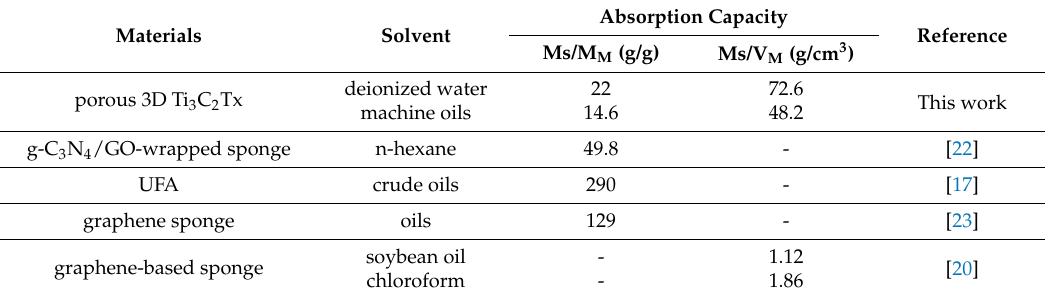
Figure 2. SEM images of the ( a ) 3D porous Ti 3 C 2 T x , ( b ) skeleton construction, ( c ) pores in the wall, and ( d ) 3D porous Ti 3 C 2 T x -NiO composite with weight ratios of 2:1. Table 1. Summary of absorption capacities of formulated 3D porous Ti 3 C 2 T x compared to the values reported in other literature.